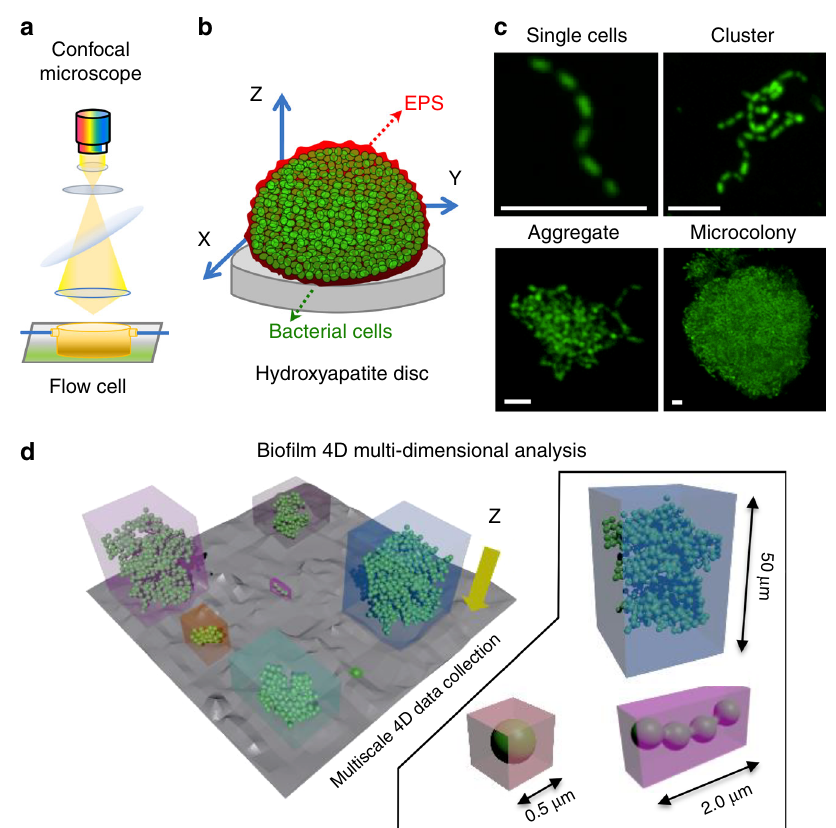
Fig. 1 Setup of the confocal laser scanning microscope (CLSM) and the image-processing software (BioSPA) to perform the spatial population-growth analysis over time. a Experimental setup for analyzing microbial colonization and further growth under fl ow in situ using confocal laser scanning microscopy-surface topography imaging approach. b Schematics of bio fi lm constituents detected by independent signal detection of bacteria (green), exopolysaccharides substances (EPS; red), and hydroxyapatite disc (HAD) surface (gray). The HAD is placed inside the fl ow cell in the position as shown in the diagram. c Representative Z -projection (max intensity) of the CLSM images depicting the evolution of a surface colonizer (single cells, cluster, aggregate) into structured communities (microcolony). White bars: 5 µ m. d Schematics of the image-processing method to capture the population units (i.e., single cells, clusters, aggregates, and microcolonies) across time and space, i.e., three dimensions and at multiple scales. The data were analyzed using bio fi lm spatiotemporal population analysis (BioSPA)